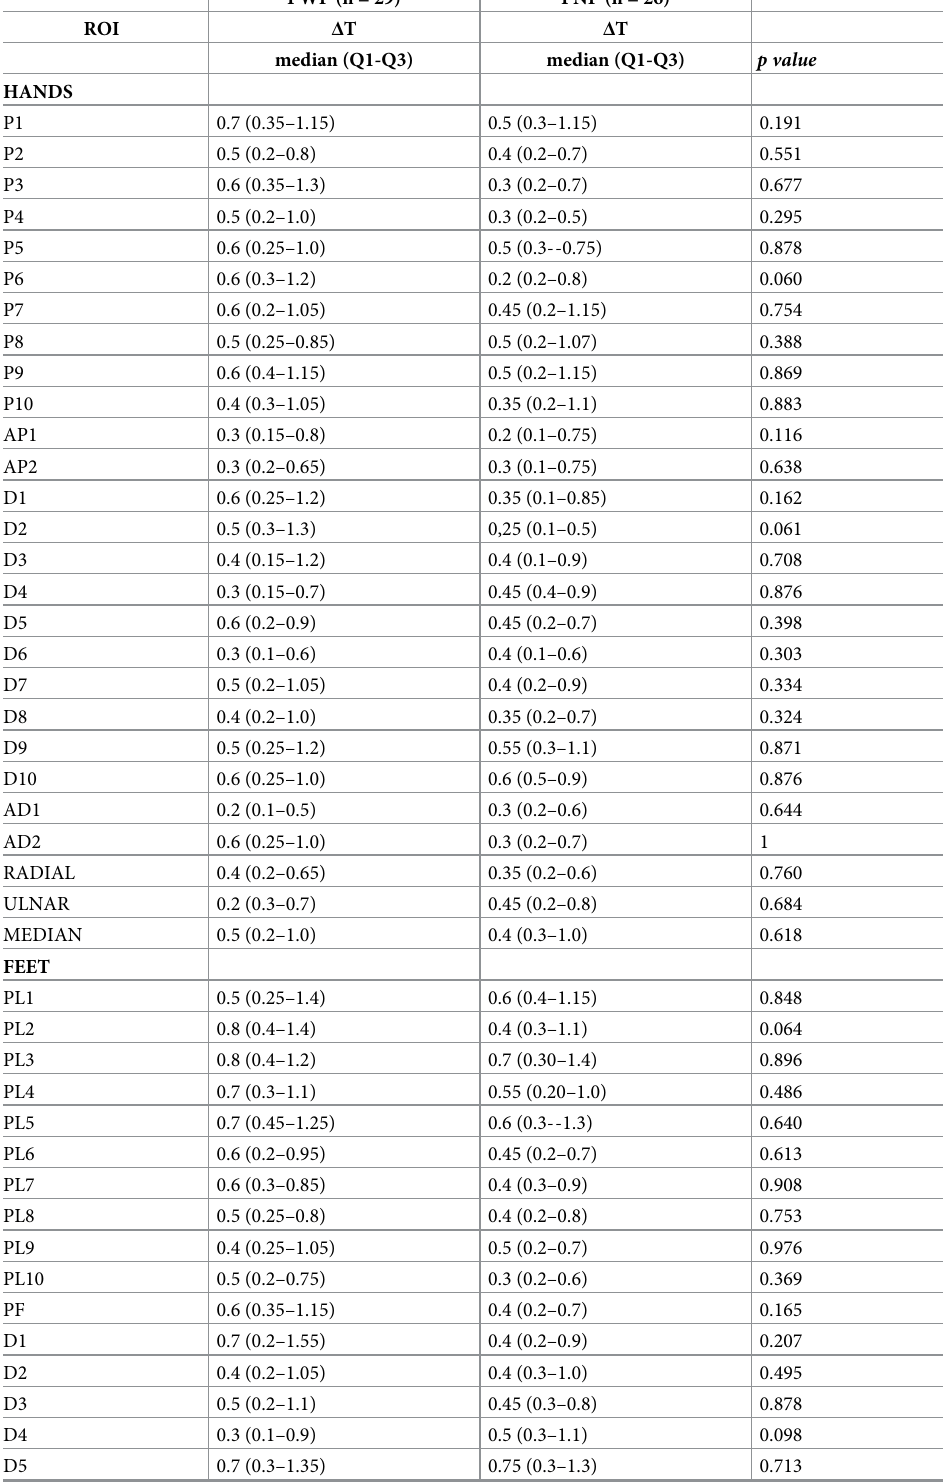
Table 3. Comparation of Δ T in the ROIs and neural areas of hands and feet in the PWP and PNP